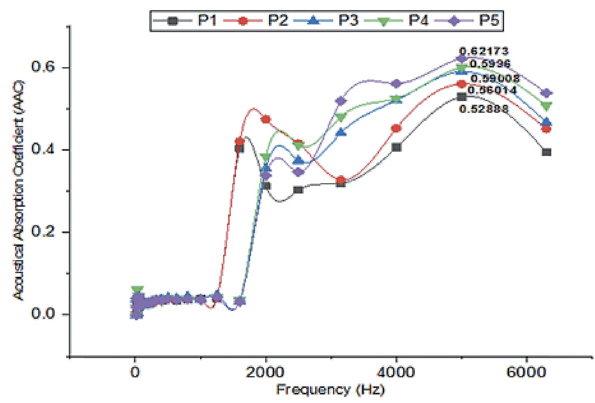
Figure 4: Sound absorption coe ffi cient at various ranges of fre - quencies ( 179 ) . Copyright © 2021, Taylor & Francis.